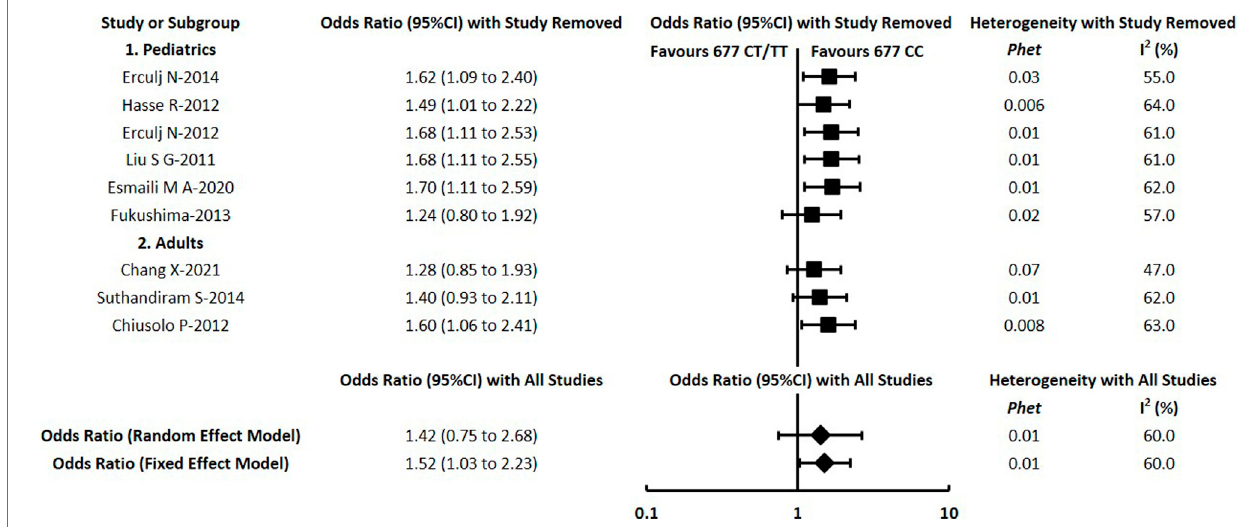
FIGURE 4 | Sensitivity analysis for meta-analysis of the association between MTHFR (rs1801133) and hepatotoxicity under the dominant